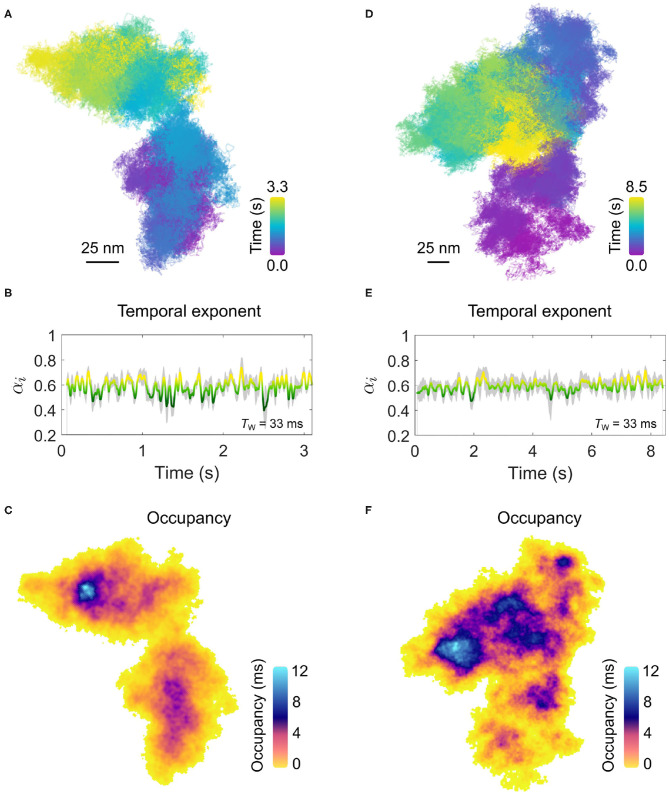
Confinement on the plasma membrane of a COS-7 cell. (A) The trajectory for an example of confined EGFR-GNP diffusion on a COS-7 cell is presented. The imaging framerate of 30,000 fps for a total of 3.3 s gives a total of 100,000 trajectory points. (B) The temporal exponent for the trajectory in (A) with an averaging window of Tw = 33 ms. (C) The respective ATOM plot for the trajectory of (A) is presented in (C). The areal bin size is 4 × 4 nm2 and patches of extra-ordinary residence are reflected in the non-uniform color scale encoding total occupation time. (D) The trajectory for a second example of confined membrane diffusion, recorded at the same framerate as (A), but for 8.5 s, giving a total of 250,000 recordings. (E) The corresponding temporal exponent for the trajectory in (D) with an averaging window of Tw = 33 ms. (F) The ATOM plot for the trajectory of (D), with an areal bin size is 4 × 4 nm2.